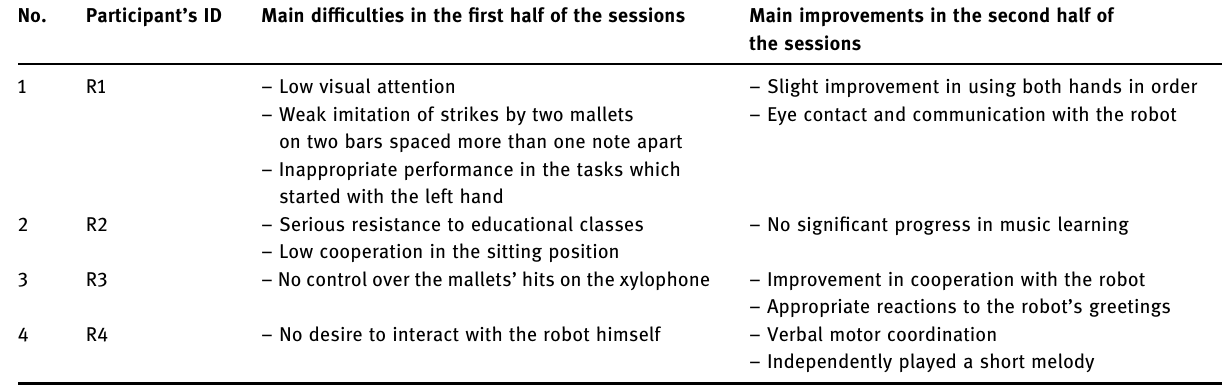
Table 3: The main qualitative di ffi culties of the participants in the fi rst half and their main improvements in the second half of the program